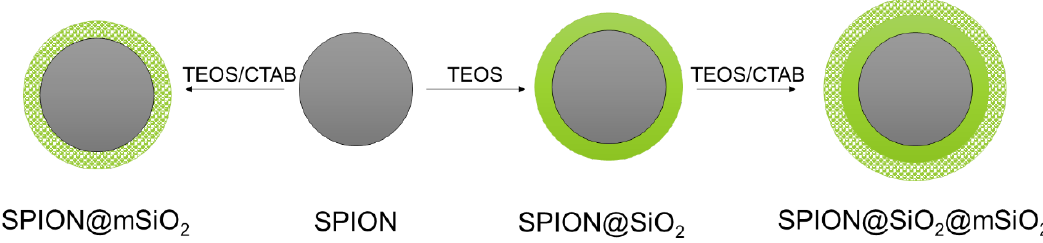
Figure 1. Schematic representation of the modification of superparamagnetic iron oxide nanoparticles